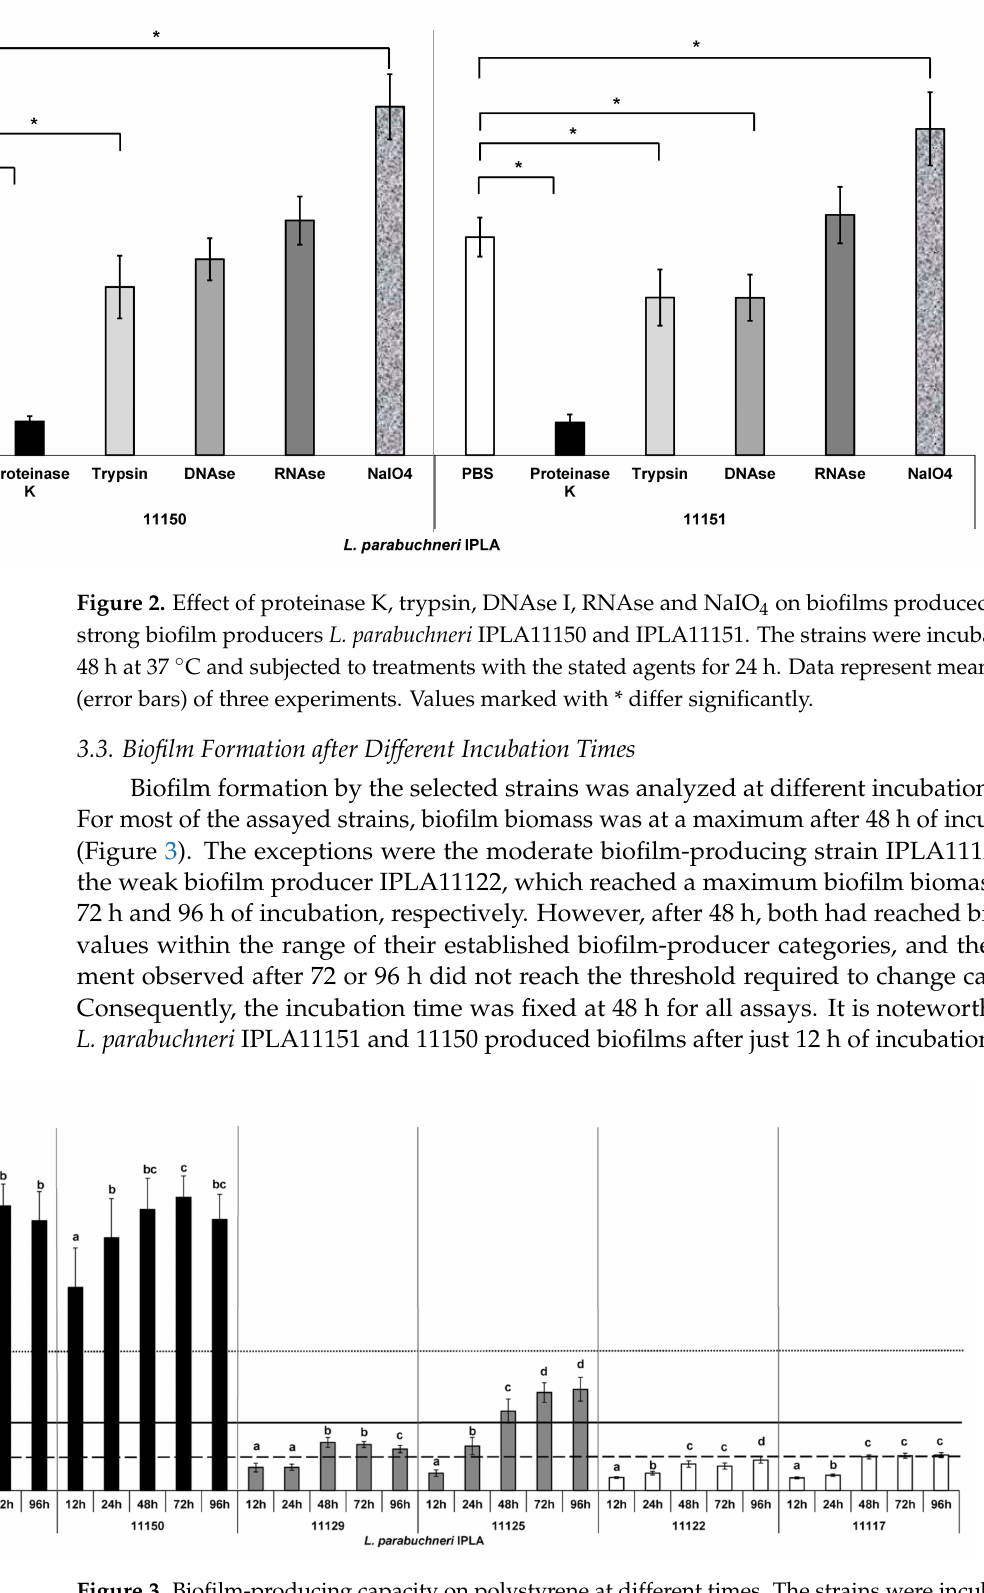
Figure 3. Biofilm-producing capacity on polystyrene at different times. The strains were incubated at 37 ◦ C for 12, 24, 48, 72 and 96 h. Data represent means ± SD (error bars) of three experiments. For